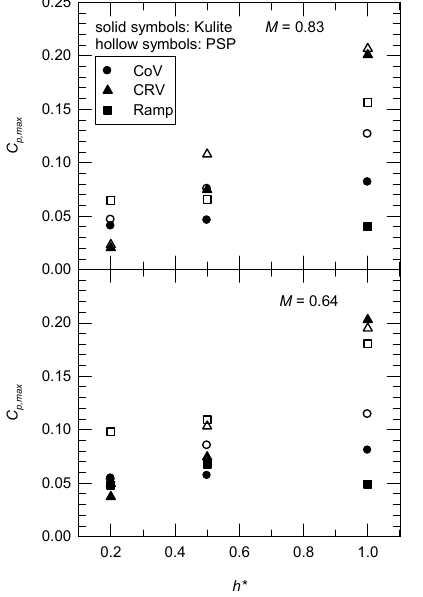
Figure 9. The e ff ect of CoV VG on the centerline surface pressure distribution for M = 0.83. 0.000.050.100.150.200.25 Rampsolid symbols: Kulite M = 0.83 hollow symbols: PSP CoV CRV m a x C p ,